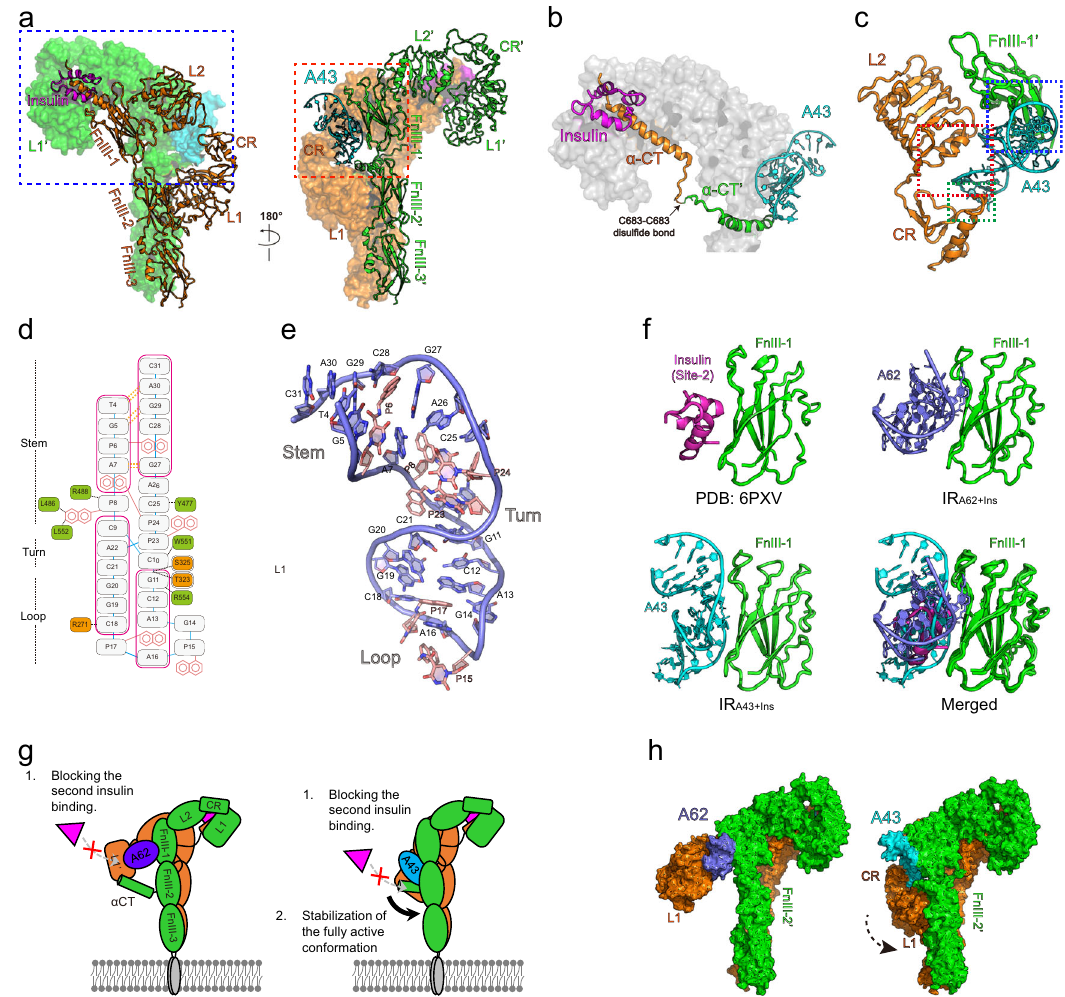
Fig. 3 | Cryo-EM structure of the IR Ins+A43 complex. a Half-turn views of the IR A43+Ins structure. Each protomer of a dimer is colored green or orange. The A43 aptamer iscoloredcyanand the insulin is colored magenta. b Close-up view of the α CT- α CT ′ crosslinked bridge between insertdomains(blue boxin Fig. 3a). c Close- up view of the A43binding site located at the CR,L2,and FnIII-1 ′ domains (red box in Fig. 3a). d Cartoon representation of the A43 structure. Labels for the 2 ′ -deoxy- ribose sugar (d) are omitted for clarity. The A43-interacting residues are shown in